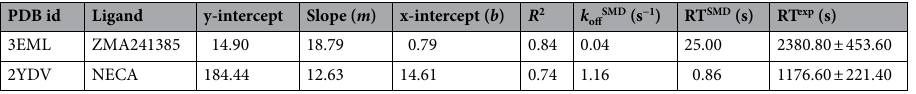
Table 2. Estimated statistics from the linear least-square regression of the average maximum unbinding forces ( F R max ) versus natural logarithms of the LR calculated from the SMD simulations of (a) ZMA241385 and (b) NECA ligand-receptor systems, the predicted dissociation rate constant ( k off SMD ) and the corresponding residence time (RT SMD ), and the experimental residence time 32 (RT exp ) are reported.